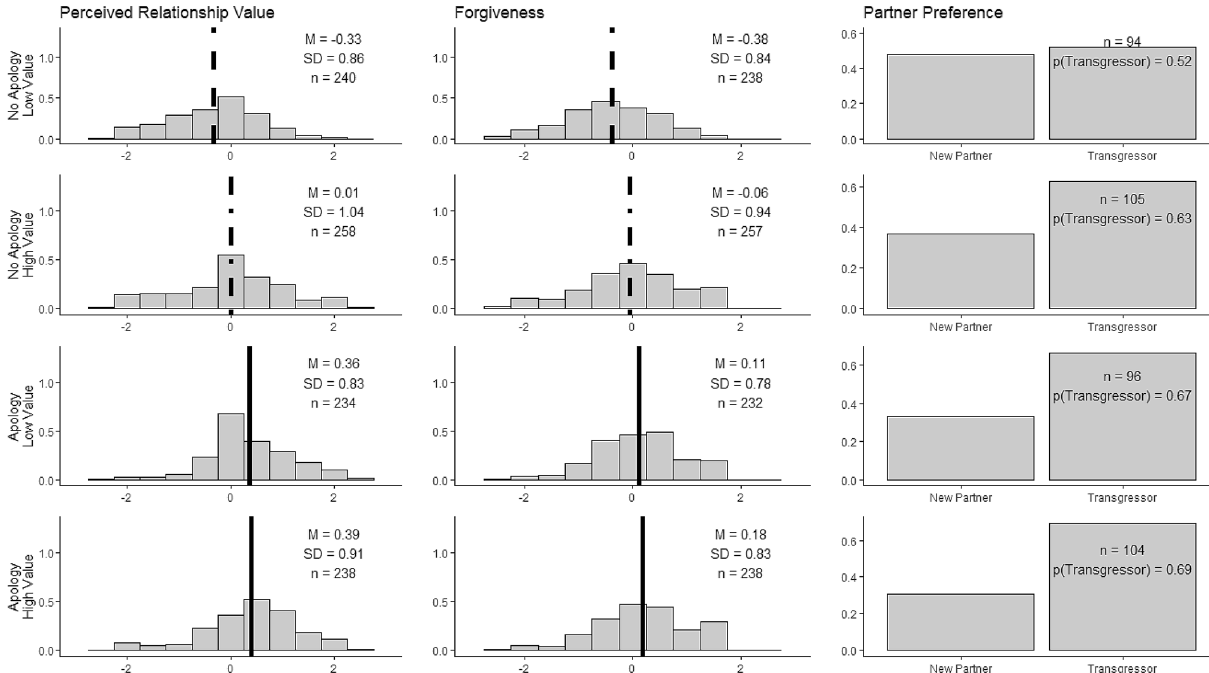
Figure 2. Histograms of participants’ factor scores representing their perceptions of the transgressor’s relationship value (post-apology), their forgiveness toward the transgressor, and bar charts of the proportion of participants who preferred to interact with their transgressors, across all four conditions. Vertical lines in histograms represent the mean. Means and standard deviations are displayed for continuous outcomes, proportion who chose interact with their transgressors are displayed for Partner Preference, and number of observations are displayed for all outcomes. For continuous outcomes, line types (solid, dashed, dot-dashed) which appear the same are not significantly different from each other.